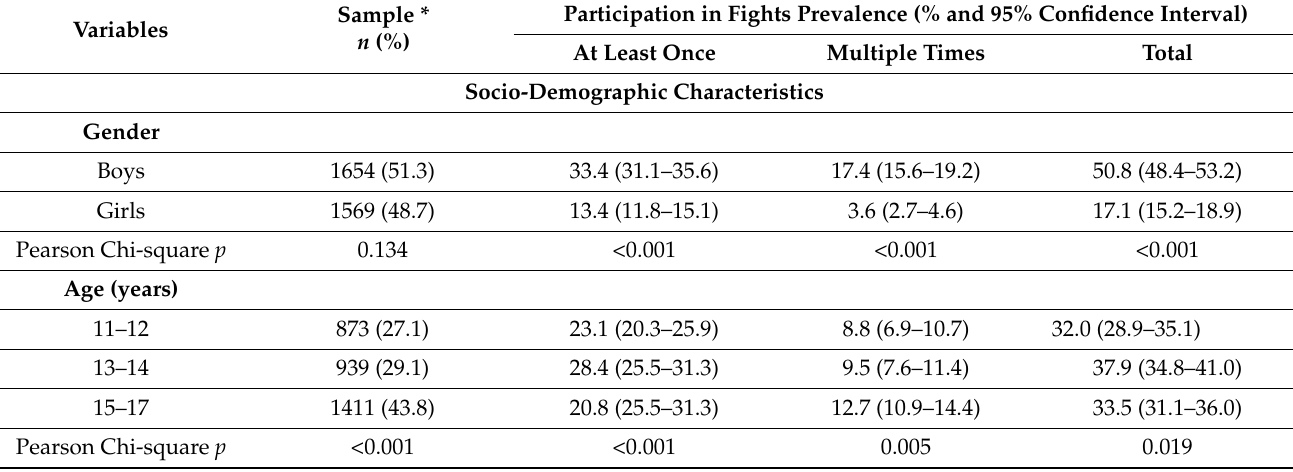
Table 1. Prevalence of participating in fights among school-age children in Serbia,